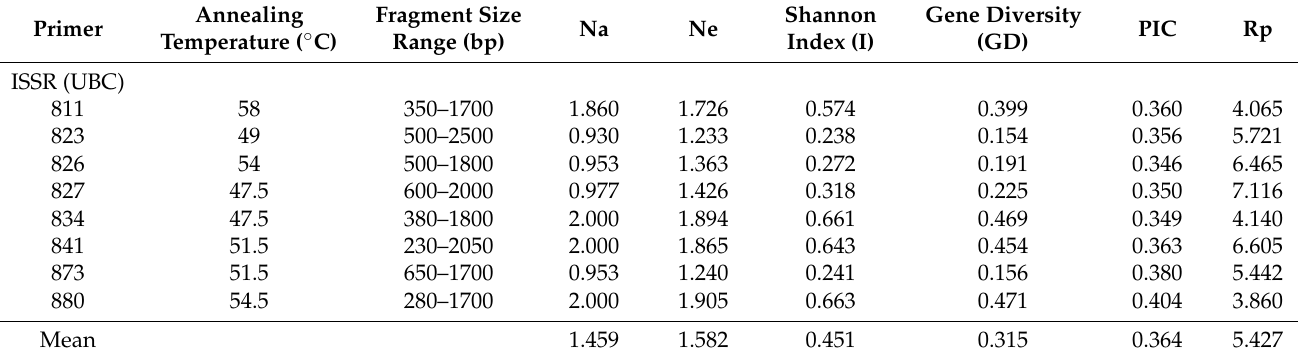
Table 4. Details of ISSR used, number of different alleles (Na), number of effective alleles (Ne), Shannon’s Information Index (I), gene diversity (GD), polymorphism information content (PIC) and resolving power (Rp) from 43 peach